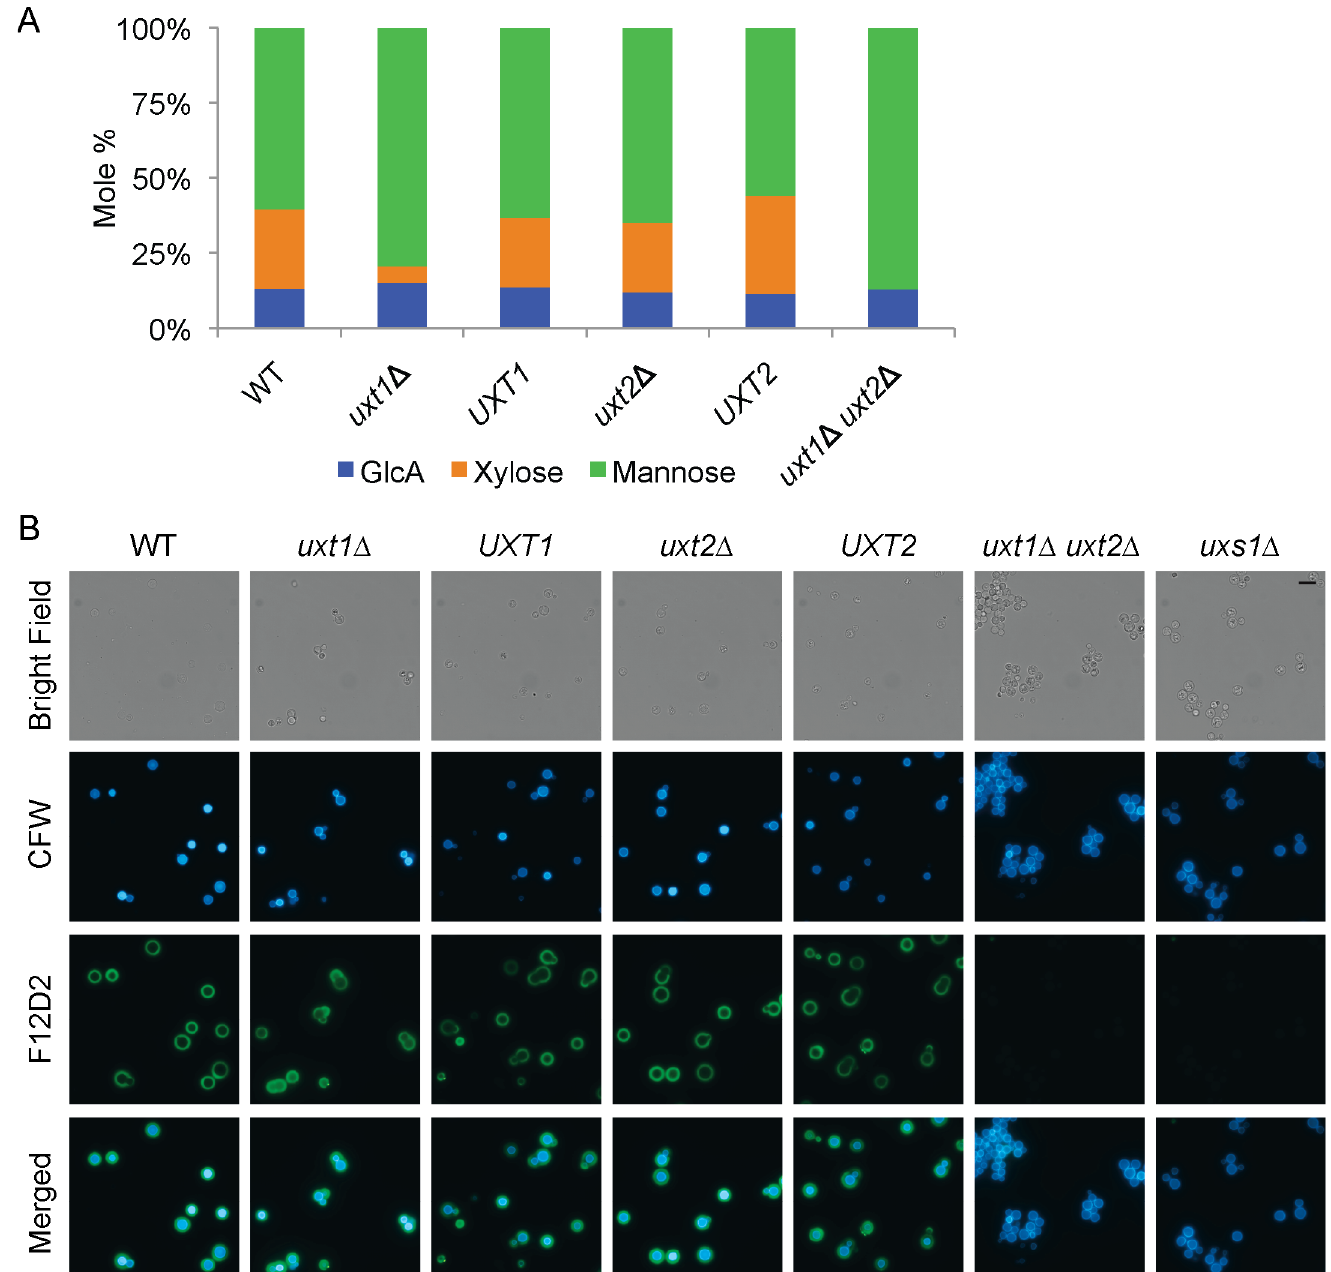
Fig 1. Capsule characteristics of uxt mutants. (A) Glycan compositionof GXM. (B) Cell wall and capsule stainingwith Calcofluorwhite (CFW; blue) and anti-GXM mAb F12D2 (green), respectively. Bright field, single channel, and merged images are shown; scale bar = 10 μ m.